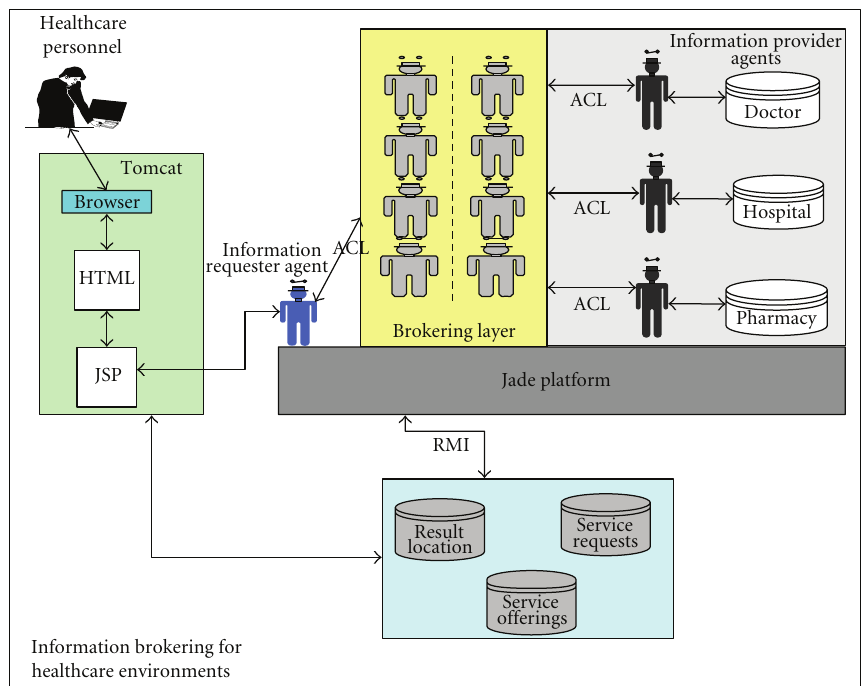
Figure 14: Privacy based brokering prototype for information gathering in